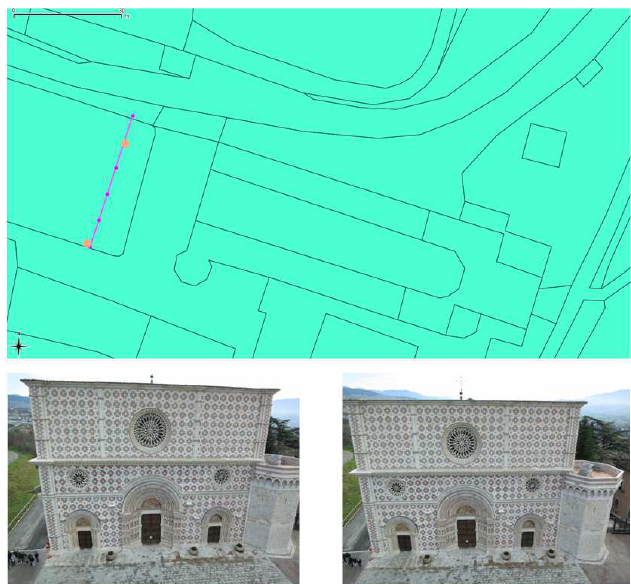
Figure 9. The stereopairs that have nearly the same geometry planned by the software